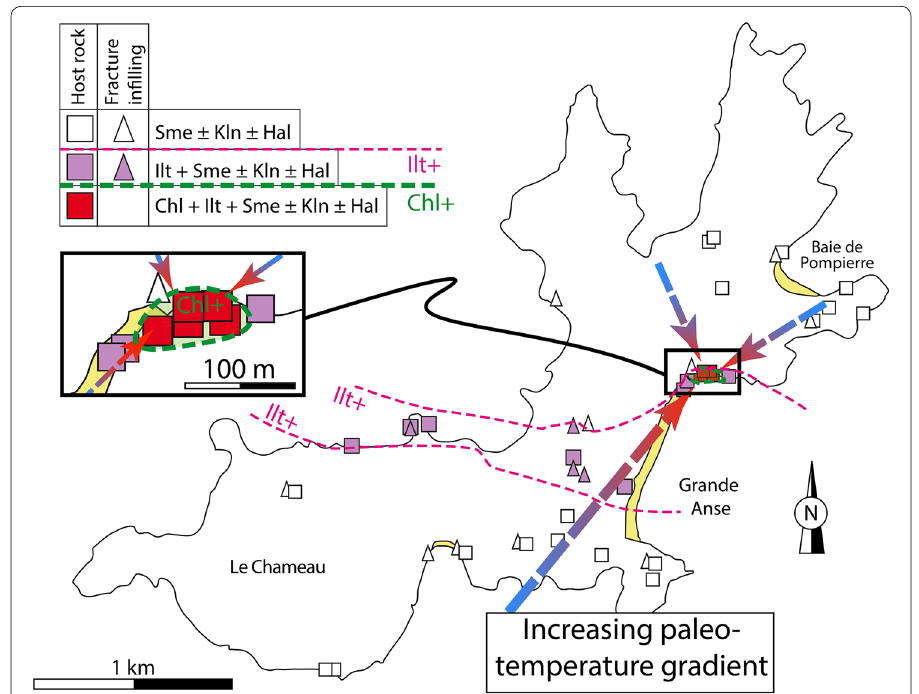
Fig. 8 Location and distribution map of the clay minerals in Terre-de-Haut island (Guadeloupe) for samples extracted from fracture infillings (triangles) and their host rock (squares). Isogrades of illite (pink dashed line) and chlorite (green dashed line) are indicated. The rectangle is a zoom on the chlorite-bearing zone (North of